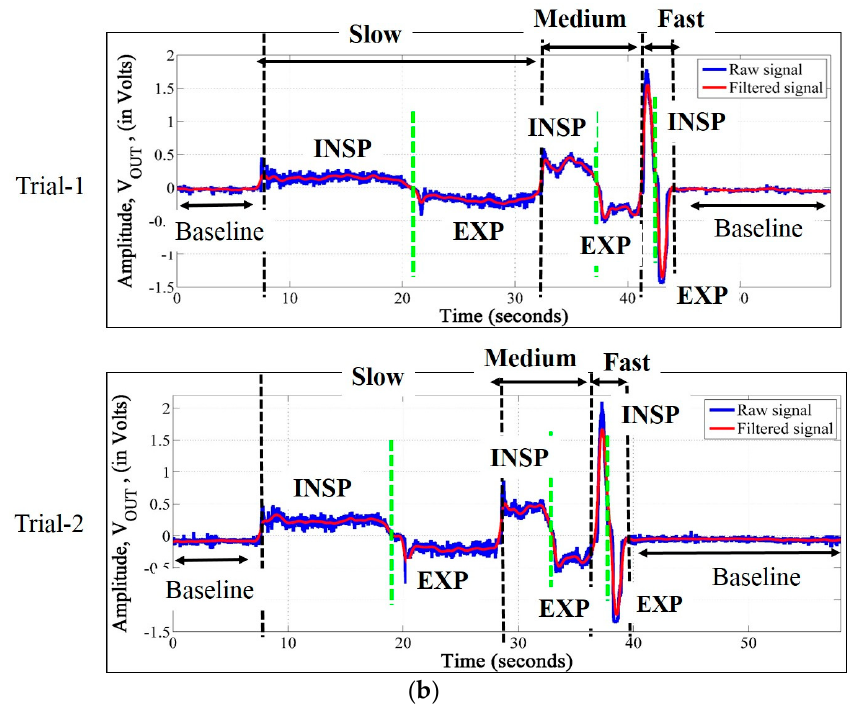
Figure 9. ( a ) The setup comprising a 3-L syringe (fitted at the mouthpiece of the blowpipe) in series with a TBP sensor during the calibration phase; ( b ) variation in the output of TBP device ( V OUT ) during slow, medium and fast rate of syringe-piston push (EXP expiration) and pull (INSP: inspiration).